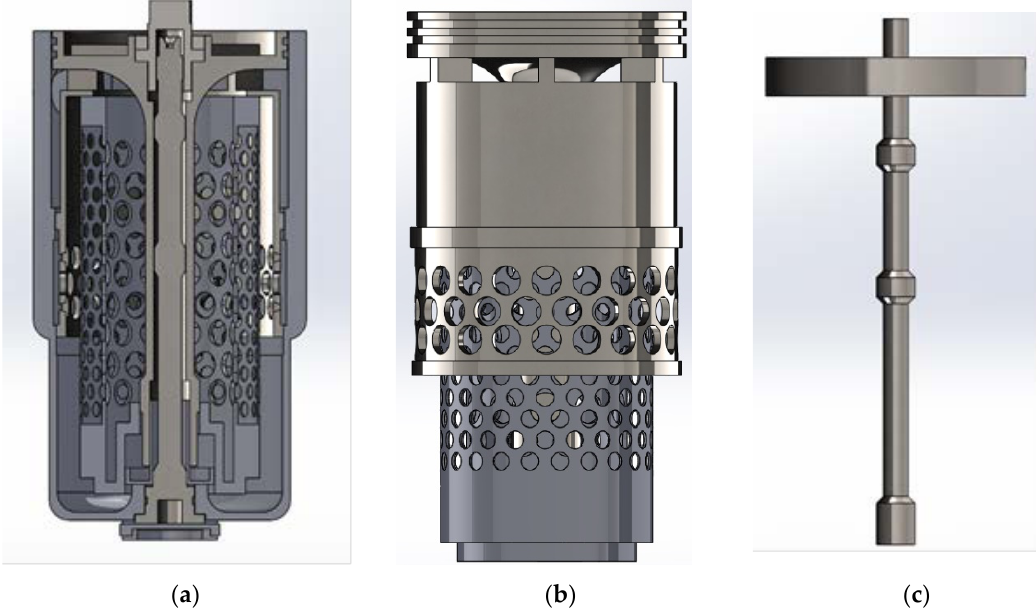
Figure 2. A computer solid model of the studied fuel system assembly: ( a ) cross-section, ( b ) view without housing, ( c ) simplified model for strength analysis.